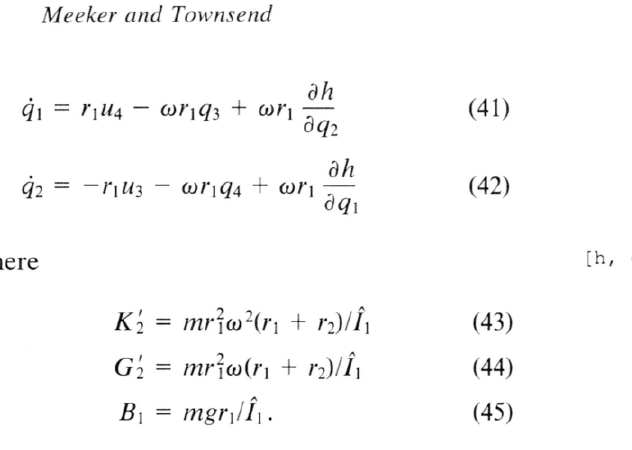
FIGURE 4 Top Secret® bowl